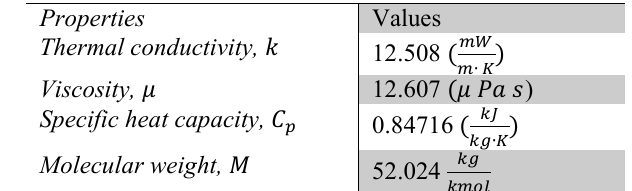
Table 1. Properties of pseudo R32 at room conditions